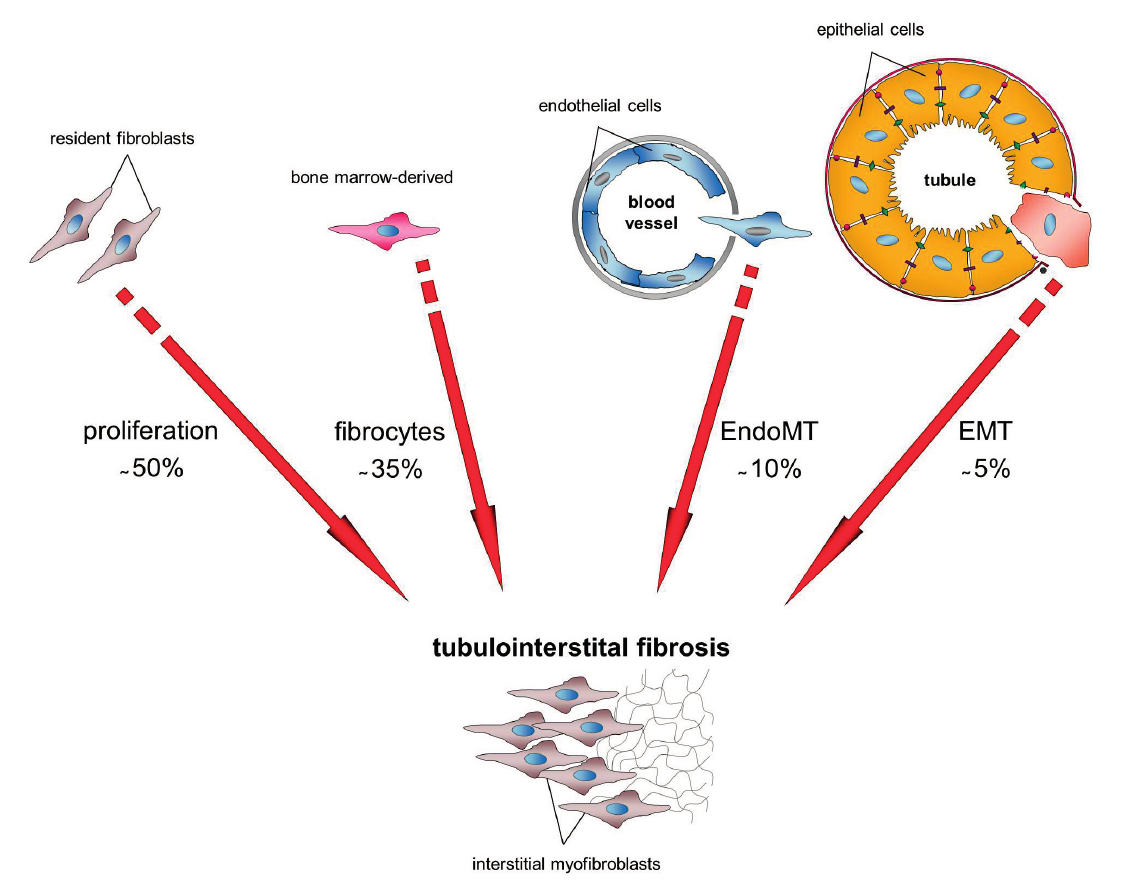
Figure 1. Current concept of origin of matrix-producing myofibroblasts that directly mediate the tubulointerstitial fibrosis. Schematic illustration shows the possible mechanisms via myofibroblasts can originate during kidney fibrosis with their proposed proportions on the total number of interstitial myofibroblasts. Recent studies estimate that approximately 35% of fibroblasts arise from bone marrow, 10% and 5% via local EndoMT or EMT, respectively, and 50% of fibroblasts result from proliferation of resident fibroblasts [32]. EndoMT (endothelial-to-mesenchymal transition), EMT (epithelial-to- mesenchymal